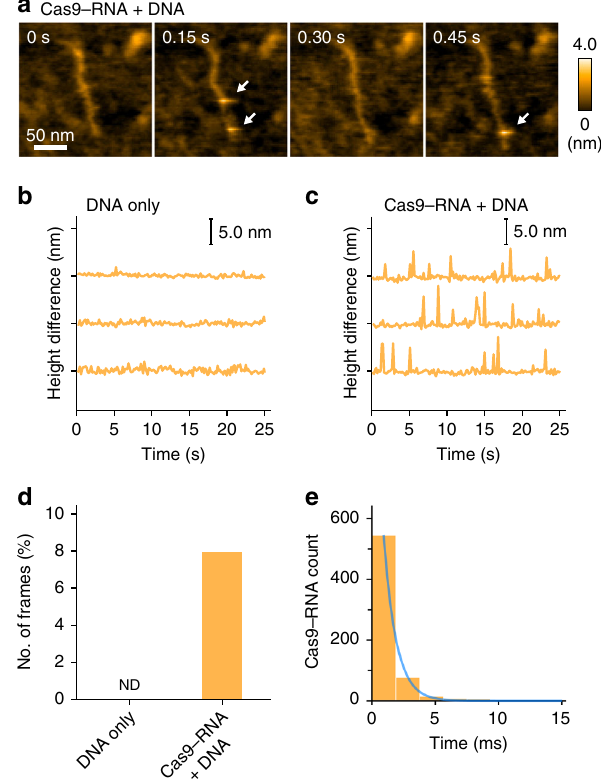
Fig. 6 HS-AFM observations of the non-speci fi c transient binding of Cas9 – RNA. a Sequential HS-AFM images of Cas9 – RNA molecules transiently bound to non-target sites of the DNA. Transient binding of Cas9 – RNA appears as a bright spot in the images, as indicated by the white arrows. Most of the binding events were completed within a single-line scanning time (1.9 ms; 150 ms / 80 lines). The scale bar is 50 nm. b , c Differences between the lowest and highest heights in each image during the HS-AFM observations of DNA only ( b ) and Cas9 – RNA – DNA ( c ). In c , the spikes indicate the transient binding of Cas9 – RNA to the DNA. d , e Frequency ( d ) and lifetime ( e ) of the transient binding of Cas9 – RNA to the DNA. The lifetime was estimated by counting the successive line numbers on which the spike-like spots were continuously seen. Spike-like spots with heights over 3.5 nm were judged as Cas9 – RNA molecules. The lifetime was fi tted by the 1st order exponential decay, with a time constant of 0.98 ± 0.02 ms ( n =